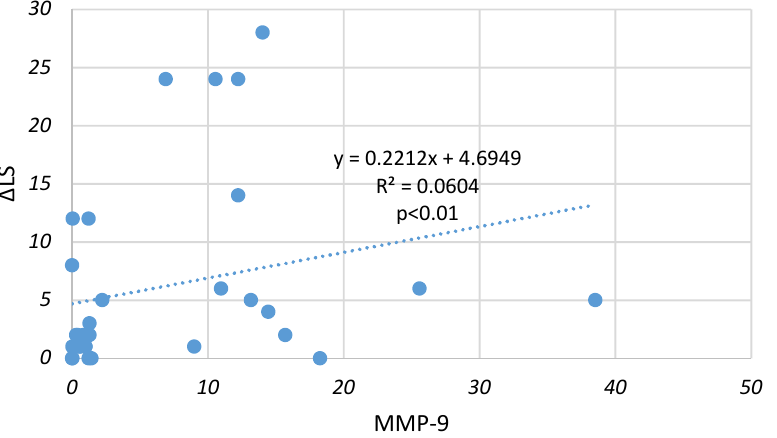
Figure 2. Correlation of MMP-9 in synovial fluid with annual changes of Larsen score ( ∆ LS) in patients with non-erosive